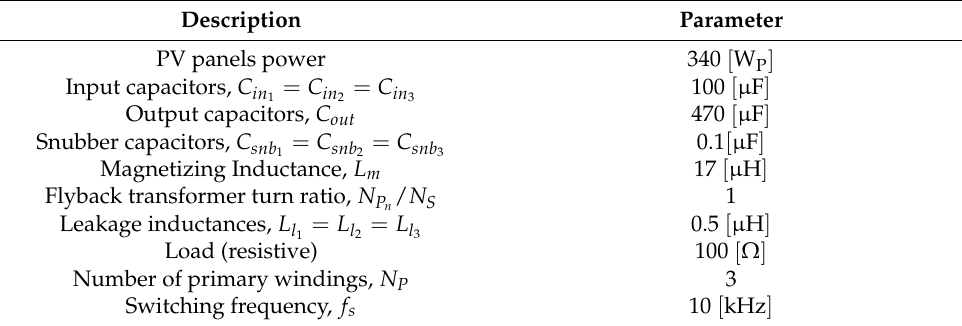
Table 1. Simulation parameters.